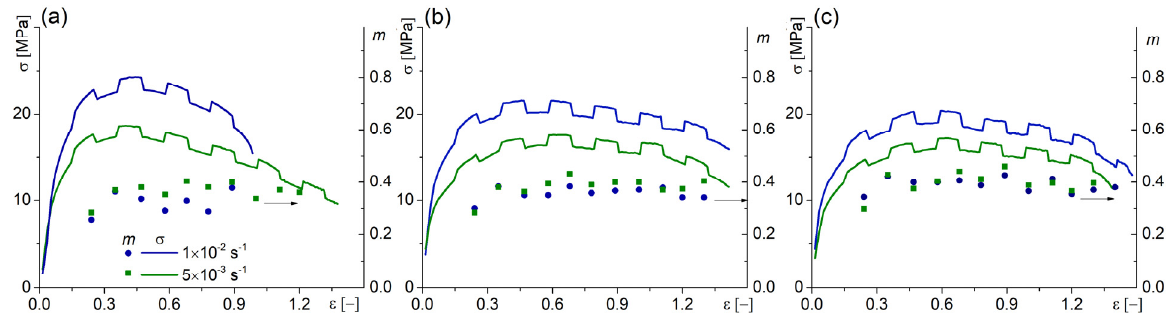
Figure 8. Strain dependence of the stress and m-value during the step test with periodically stepped true strain rate to 20% above nominal of 5 × 10 − 3 s − 1 and 1 × 10 − 2 s − 1 , then back to nominal for ( a ) 0Ce, ( b ) 2Ce, and ( c ) 4Ce alloys at 480 °C.